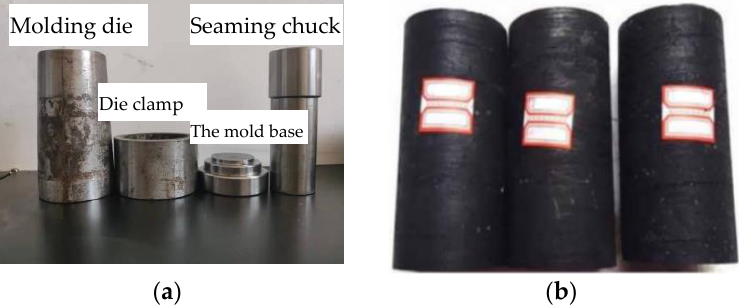
Figure 1. Briquette mold and briquette sample: ( a ) coal mold; ( b ) partial briquette coal sample.